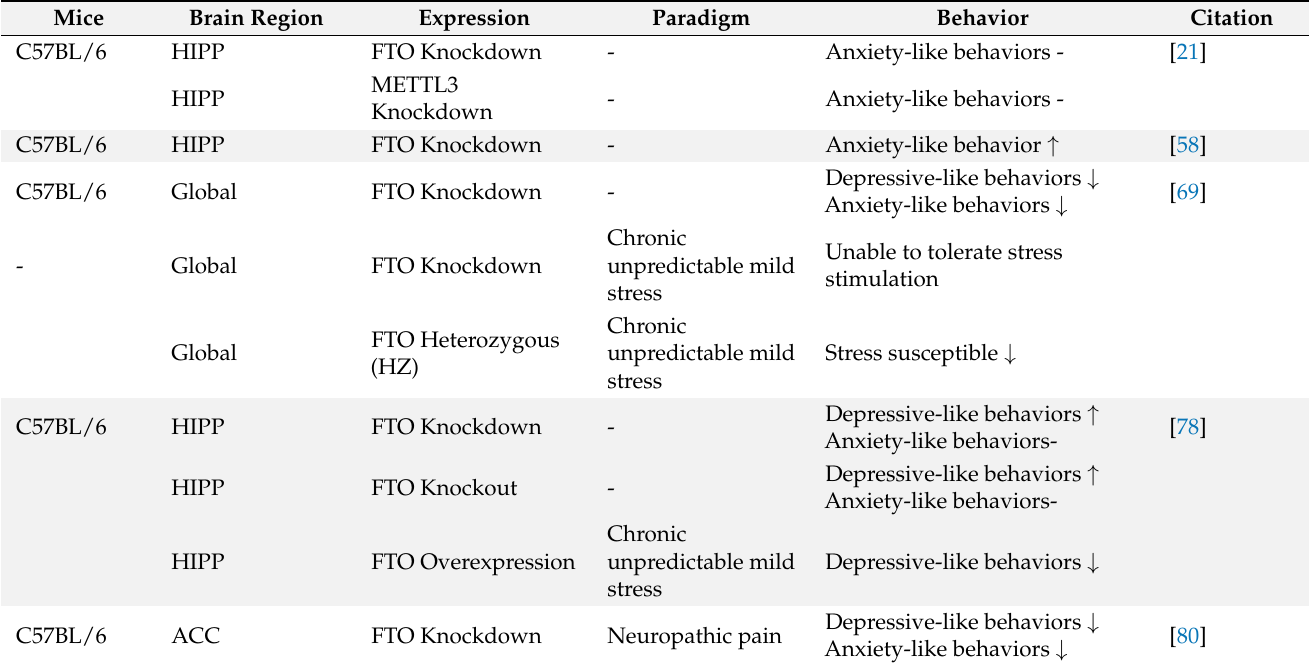
Table 1. List of studies implicating m6A regulators in depressive-like